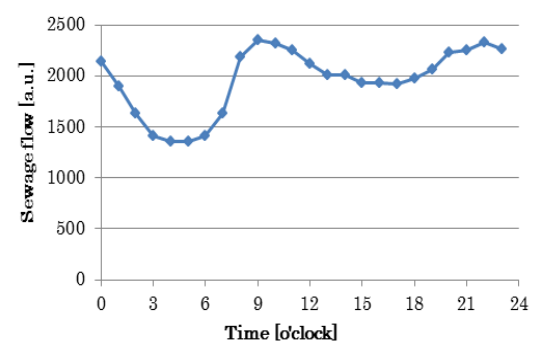
Fig. 2. Typical flow pattern not considering day